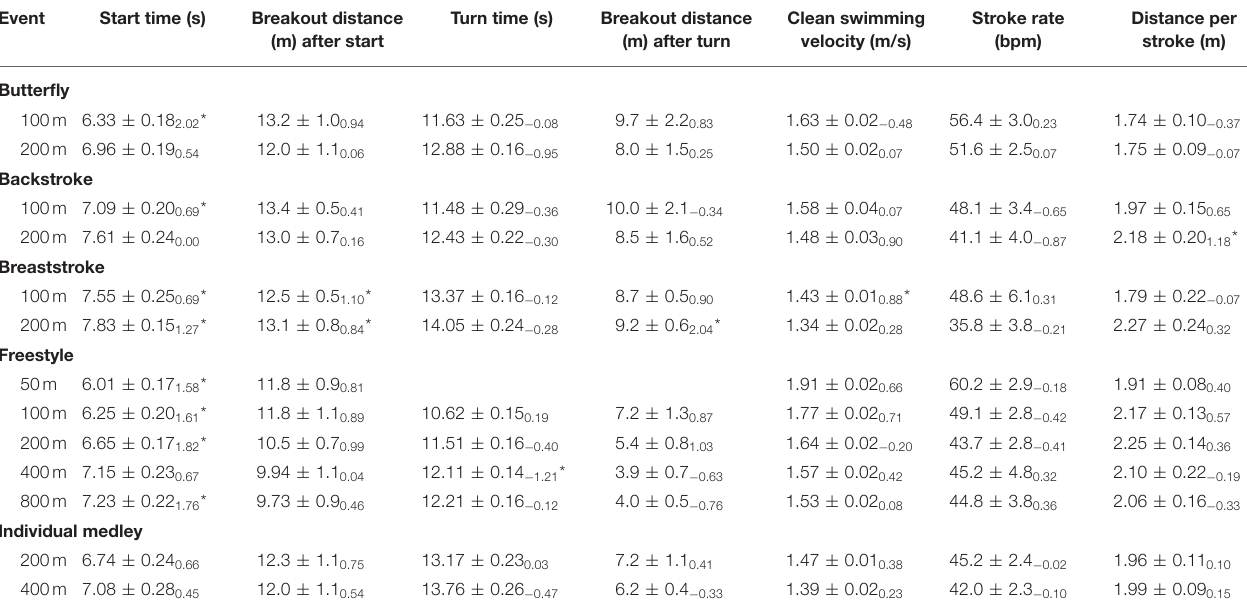
TABLE 5 | Reference values (mean ± standard deviation) for key performance indicators retrieved from female 2021 European championship finalists with significant difference (*) to the 2016 finalists. Event Start time